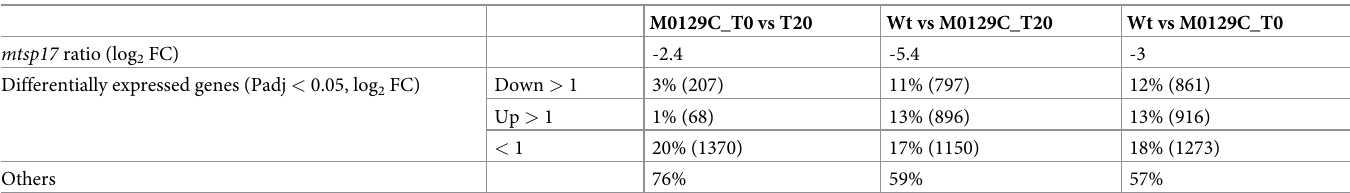
Table 1. Numbers of differentially expressed